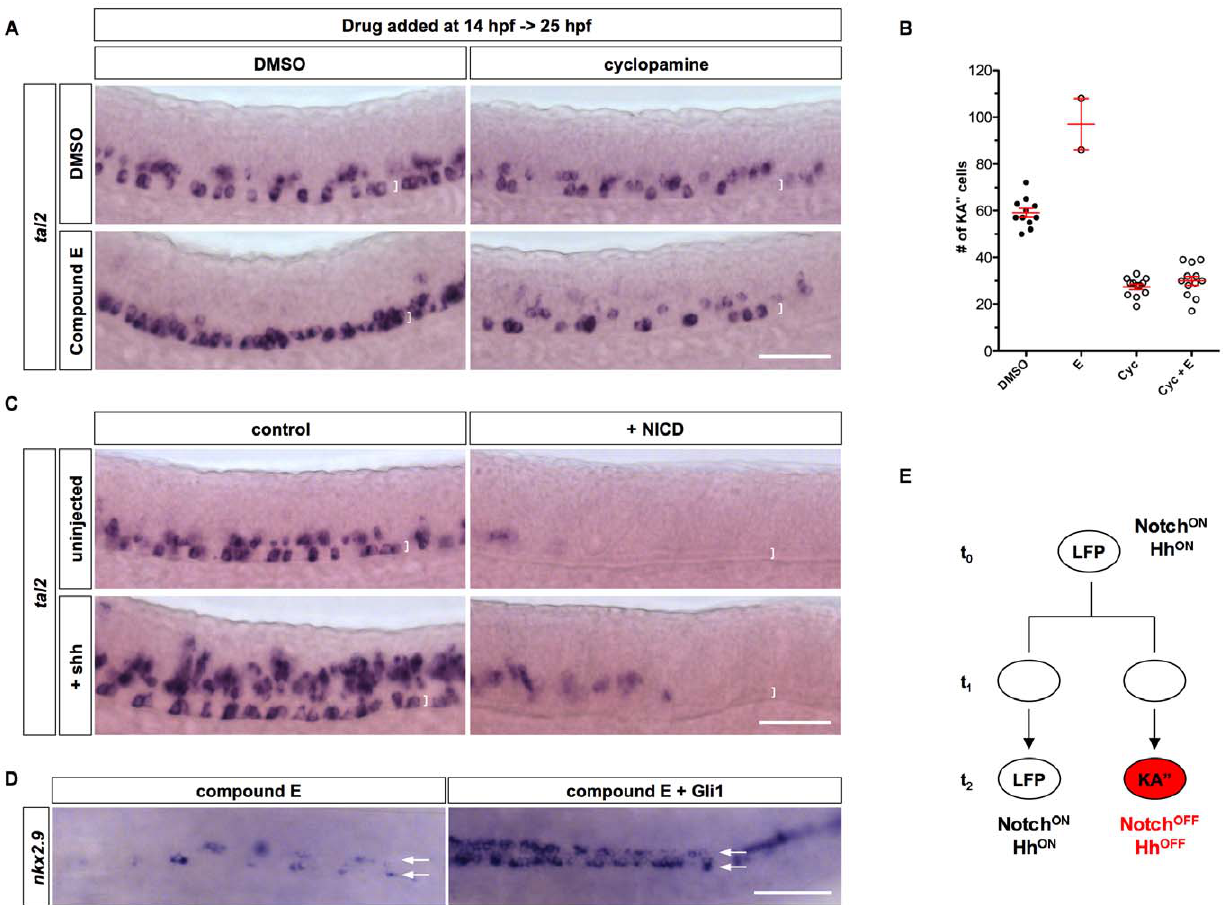
Figure 7. Interaction between Notch and Hh signaling in KA 0 specification. (A) Embryos treated with DMSO alone, compound E, cyclopamine, or both compound E and cyclopamine from 14 hpf to 25 hpf, were stained for the expression of tal2 . (B) Quantification of total number of KA 0 cells in experiments shown in A. Note that the fewer data points in compound E treatment is due to the fact that most compound E-treated embryos had many tal2 -positive cells in close clusters which prevents reliable scoring. The two data points thus underestimate the total number of KA 0 cells in E-treated embryos. Cyc: cyclopamine. (C) hsp-Gal4; UAS-NICD embryos and non-transgenic sibling controls were left uninjected or injected with Shh mRNA, heat-shocked at 11.5 hpf, and stained at 24 hpf for the expression of tal2 . Brackets in A and C indicate the dorsal-ventral extent of the LFP domain. Scale bars: 50 m m. (D) hsp-Gli1 embryos and non-transgenic controls were injected with compound E at 15 hpf, and heat-shocked at 16 hpf, and stained at 22 hpf for the expression of nkx2.9 . Arrows denote the two rows of LFP domains in dorsal views. (E) Model of KA 0 specification.